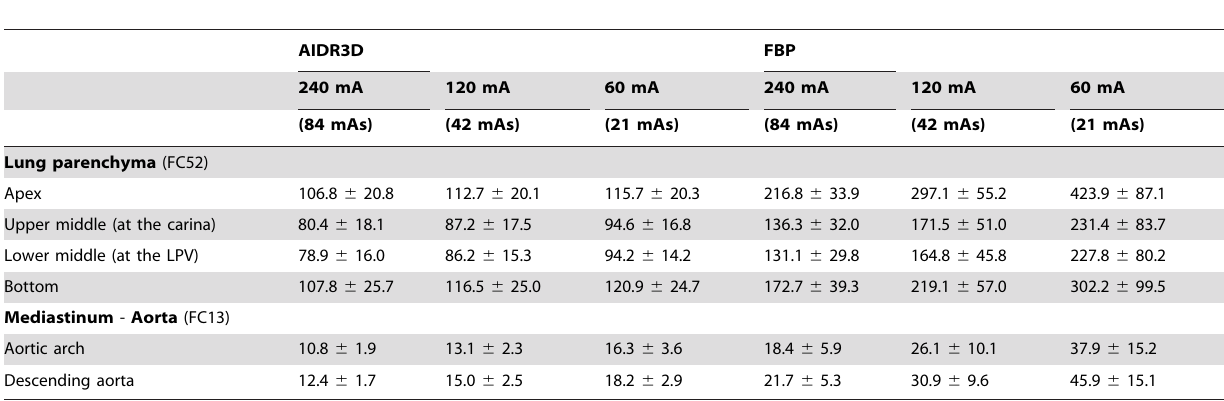
Table 3. Results of quantitative image noise (SD measurement*) at different tube currents with AIDR3D and FBP (without AIDR3D).